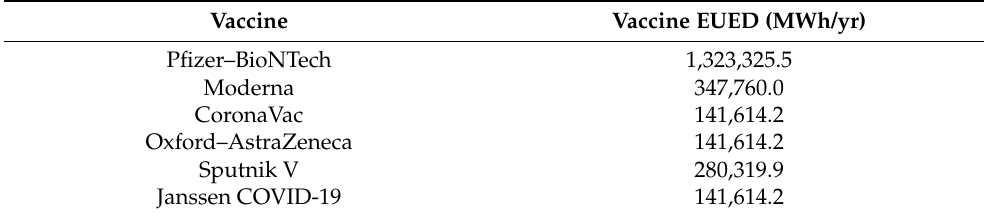
Table 6. Worldwide Vaccine